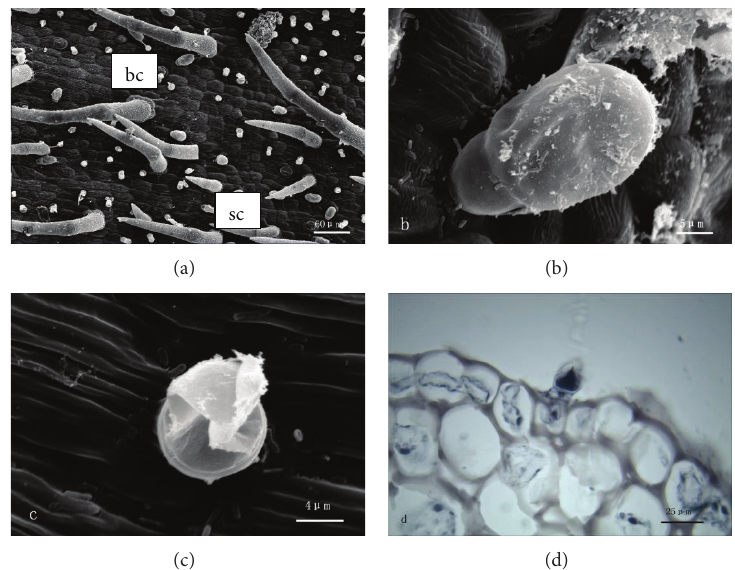
Figure 3: ((a)–(c)) SEM micrographs showing the morphology of glandular trichomes on rachis of T. quinquecostatus. (a) The surface of rachis, showing big capitate trichomes (bc) and small capitate trichomes (sc). (b) A big capitate trichome. (c) A small capitate trichome. (d) Transverse section of rachis of T. quinquecostatus , showing a capitate